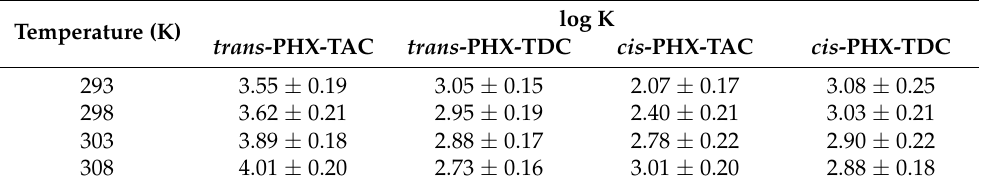
Table 1. Stability constants of the investigated interactions determined at different temperatures.